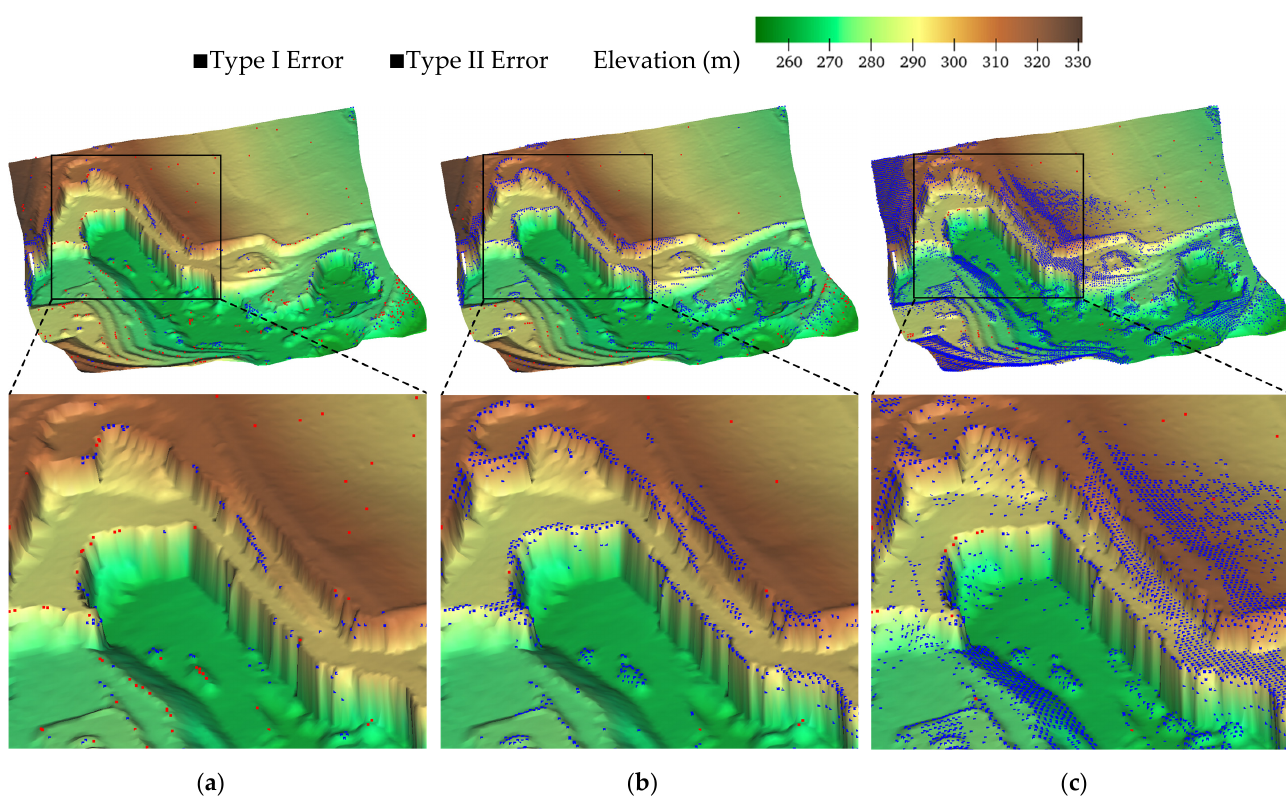
Figure 9. The error distributions of the filtering results by different filters for samp53. ( a ) Results obtained by the proposed method; ( b ) results obtained by the MHC method; ( c ) results obtained by the CSF method. The black boxes indicate enlarged displays on the steep slopes.